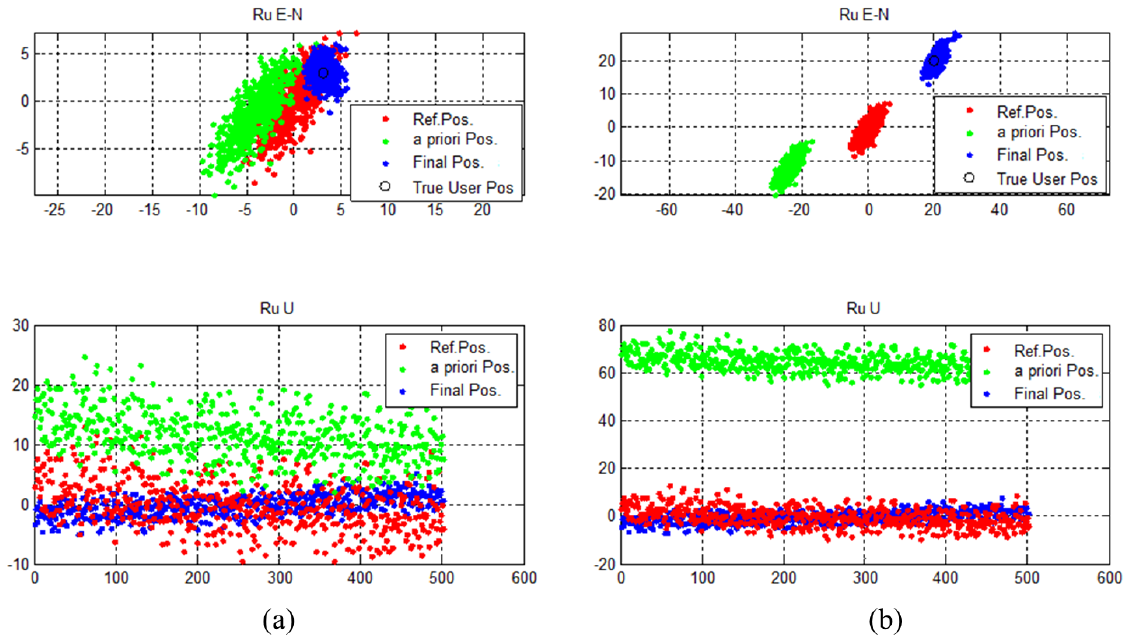
Figure 19. ( a ) Estimation results for User #1 (good DOP) ( b ) Estimation results for User #2 (poor